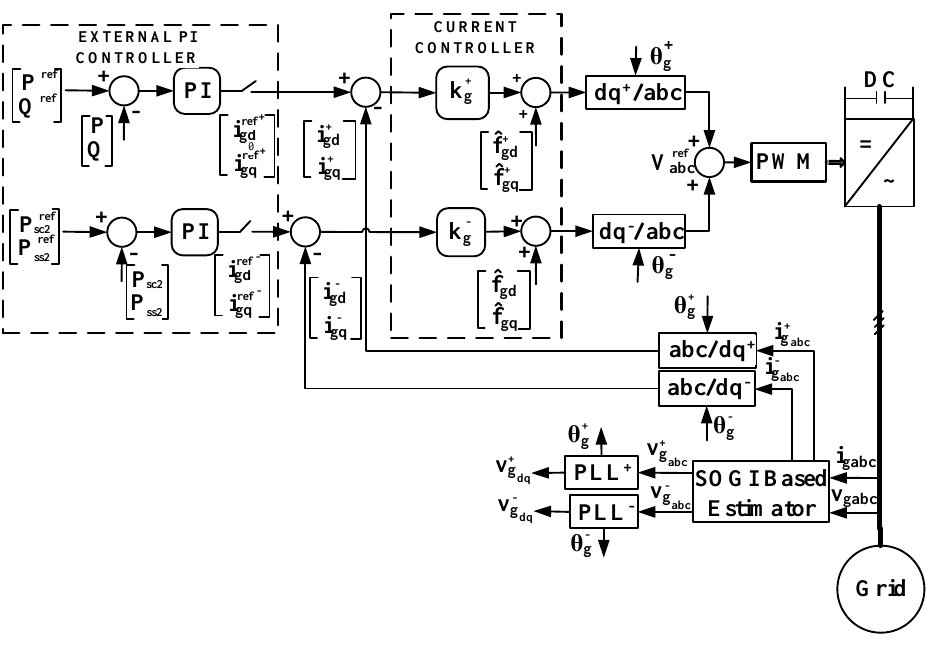
Figure 4. Proposed controller structure.